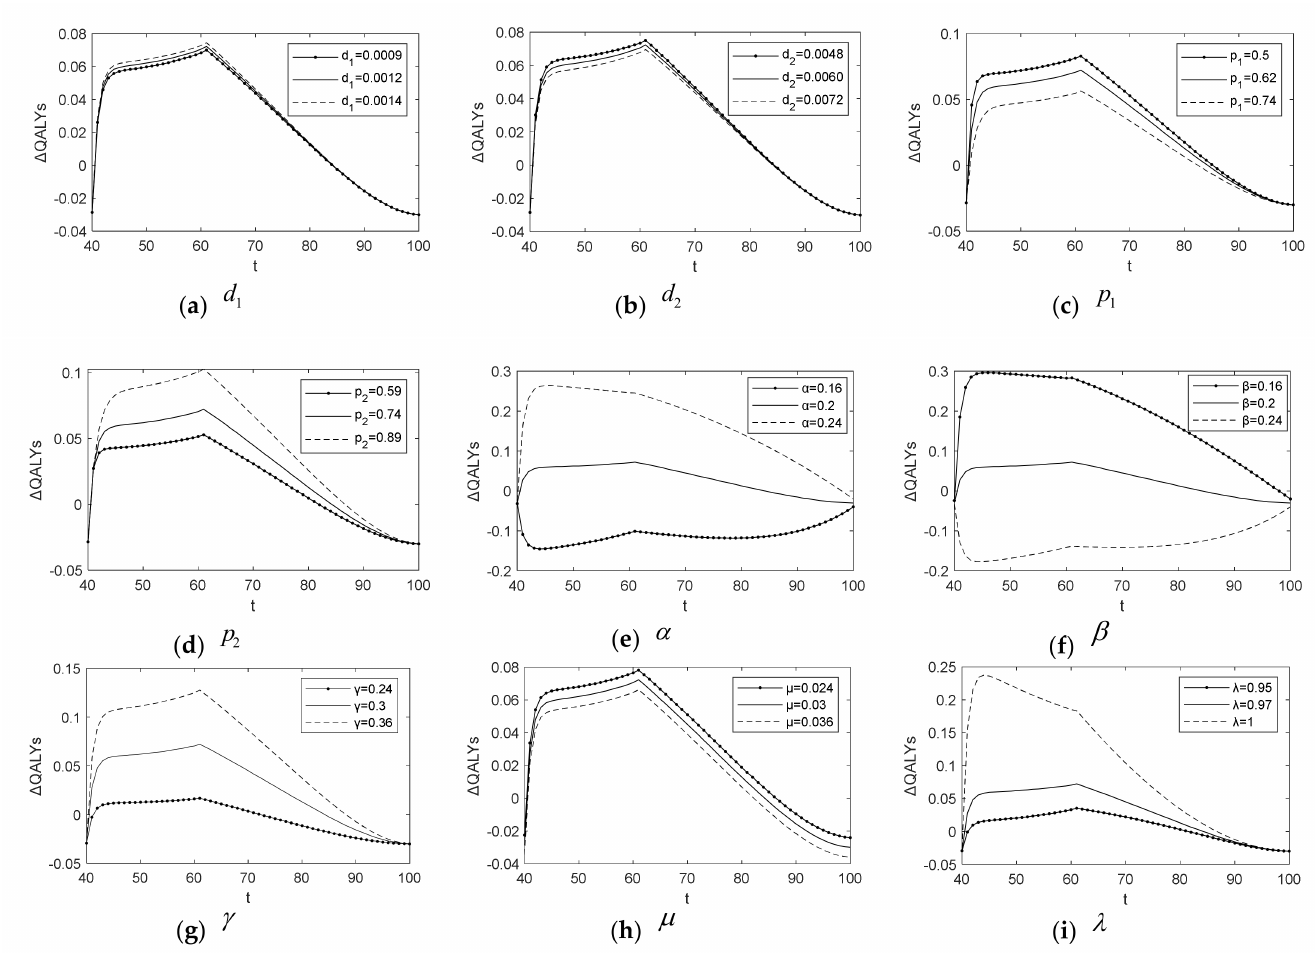
Figure 7. Sensitivity analysis for